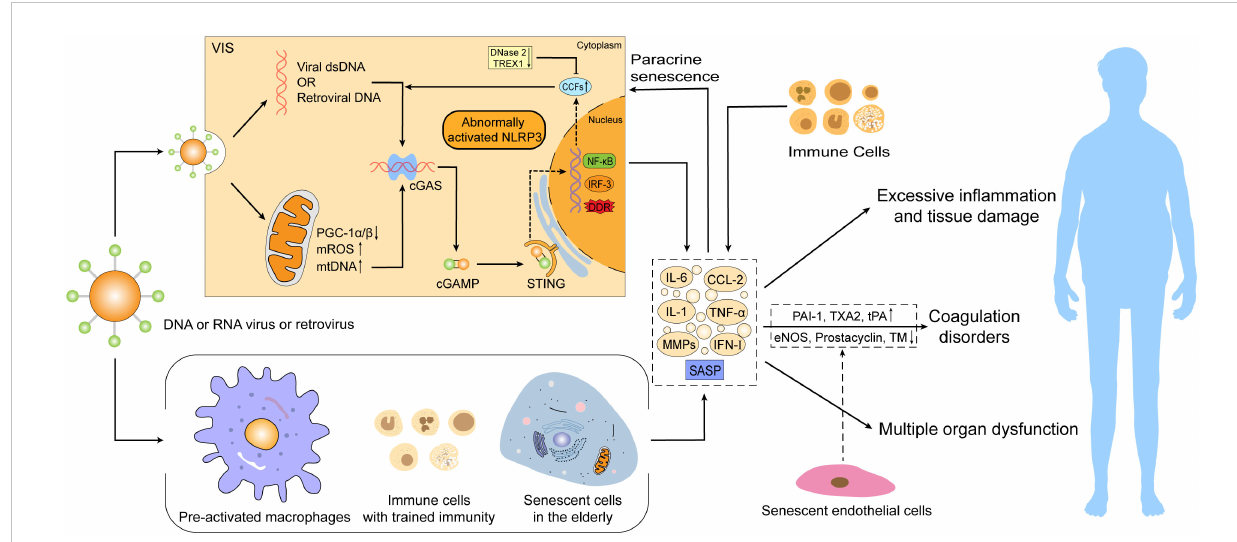
FIGURE 2 Virus-induced senescence (VIS) combined with an existing senescence in the elderly intensi fi es the severity of viral infections. Senescence can promote the development of viral infectious diseases via abnormal activation of the mtDNA/CCFs-cGAS-STING pathway and NLRP3 in fl ammasome, pre-activated macrophages, over-recruited immune cells, and accumulation of innate immune cells with “ trained immunity ” characteristics. These alterations can trigger excessive SASP production and secondary paracrine senescence, resulting in hyperin fl ammation, tissue damage, coagulation disorders, and even multiple organ dysfunction, thus leading to a higher mortality risk. SASP, senescence-associated secretory phenotype; cGAMP, cyclic GMP – AMP; CCFs, cytoplasmic chromatin fragments; DDR, DNA damage response; eNOS, endothelial NO synthase; PAI-1, plasminogen activator inhibitor-1; TXA2, thromboxane A2; TM, thrombomodulin; ROS, reactive oxygen